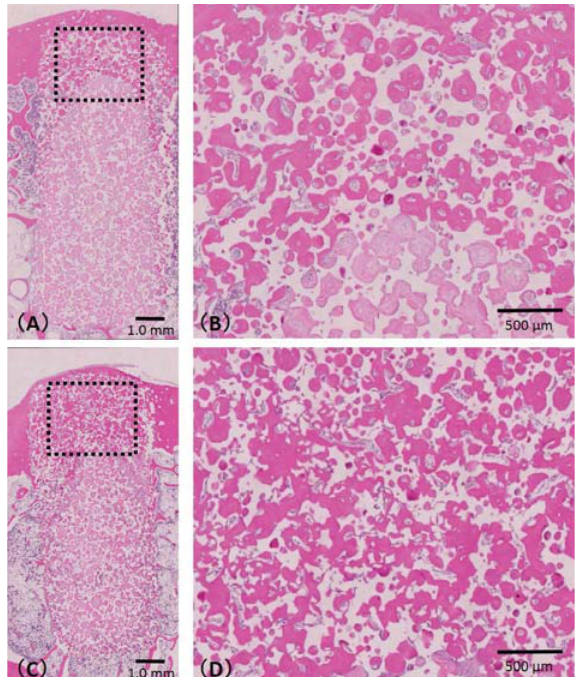
Figure 5- Histological specimen of samples A1 and A2.